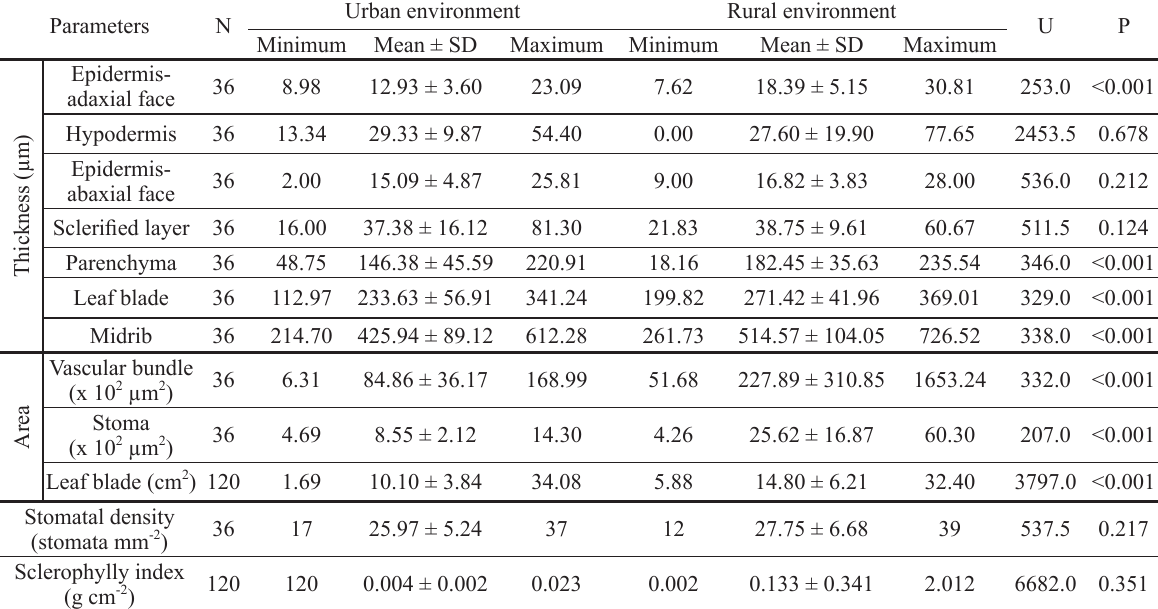
Values (mean, minimum and maximum) of morphometric parameters of Microgramma squamulosa sterile leaves in urban and rural environments (N=number of measured leaves per environment; SD=standard deviation; U=Mann Whitney test;